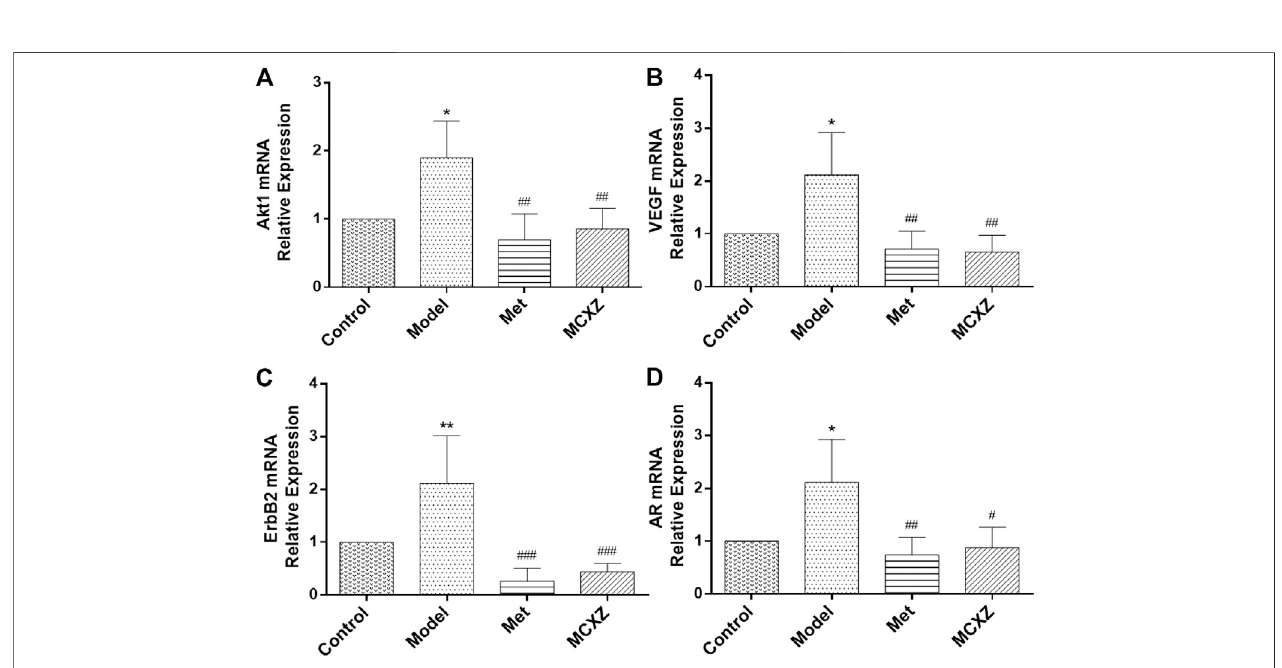
Frontiers in Pharmacology |